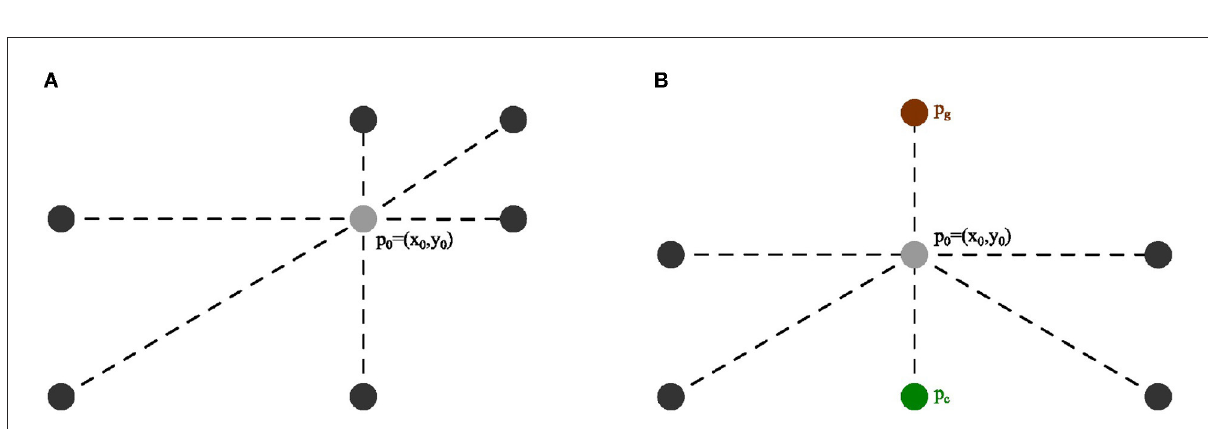
FIGURE5 (A) Support nodes in the star at an inner node. (B) Support nodes in the star at a Neumann boundary node.